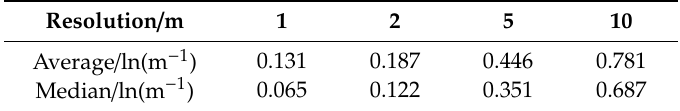
Table 1. Average and median of TCI deviations at four resampled resolutions.